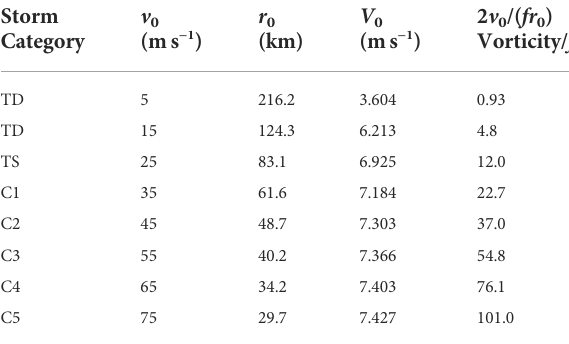
TABLE 3 Rankine vortex properties for a variety of storm categories, ranging from tropical depression (TD), to tropical storm (TS), to the fi ve hurricane categories (C1 – C5), and computed using Eq. 20 with R 0 =300 km and f =5×10 – 5 s − 1 . A range of values of the maximum physical azimuthal wind v 0 is speci fi ed in the second column followed by computed values in the next three columns of the radius of maximum wind r 0 , the maximum transformed azimuthal wind V 0 ,andthequantity2 v 0 /( fr 0 ),whichcanbeinterpretedasthe core ’ srelativevorticity,measuredin unitsof f .Sincethe validityof the linearized dynamics discussed in Section 3 requires that 2 v 0